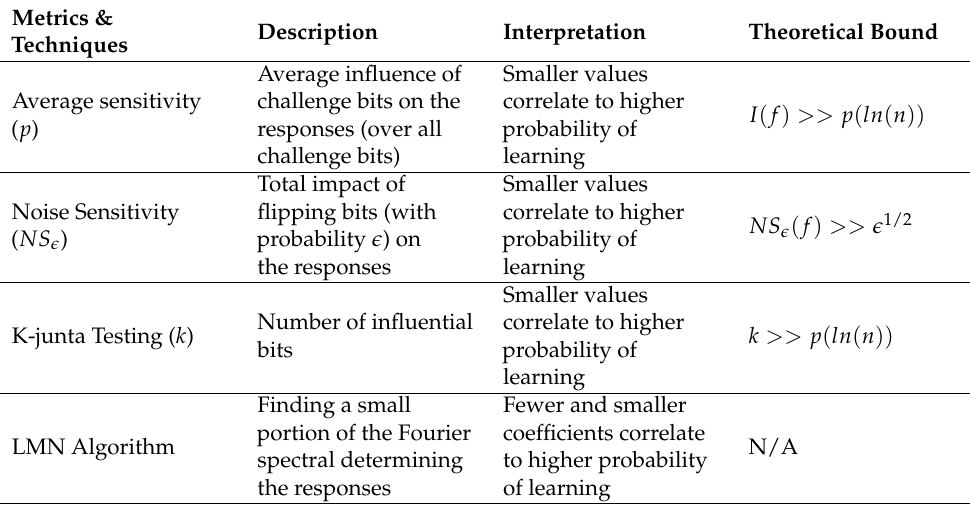
Table 3. Notion and techniques that are introduced and used in